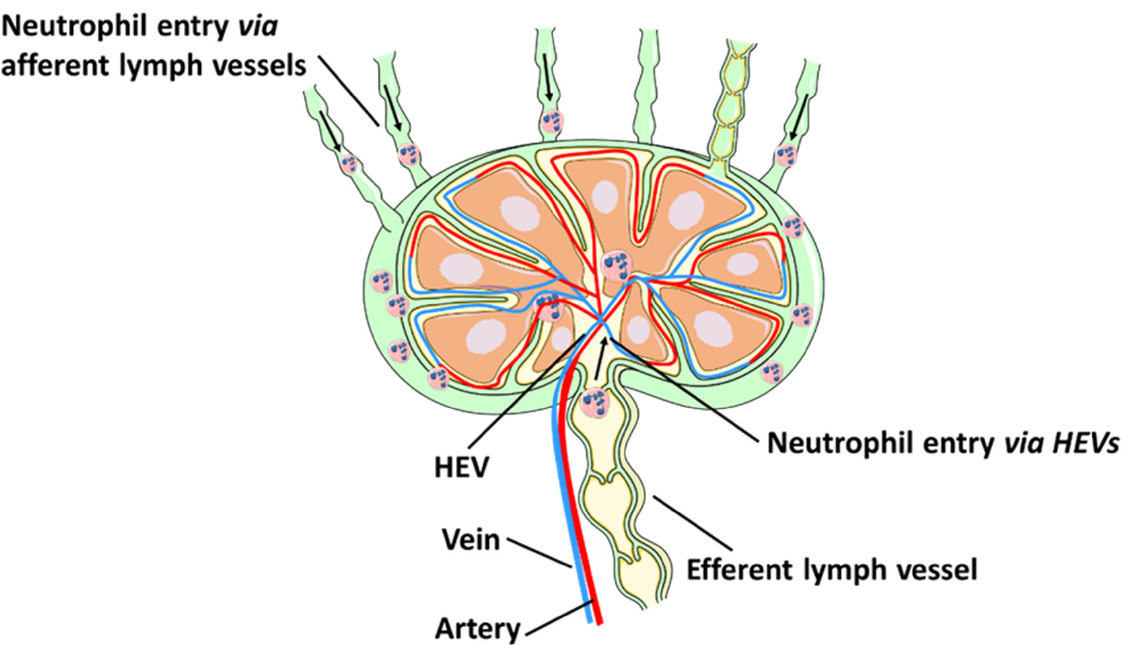
Figure 1. Neutrophil migration to lymph nodes. Neutrophils rapidly migrate from the site of inflammation into lymphatic vessels and draining lymph nodes. Neutrophils can also enter the lymph nodes from circulation by crossing HEVs.